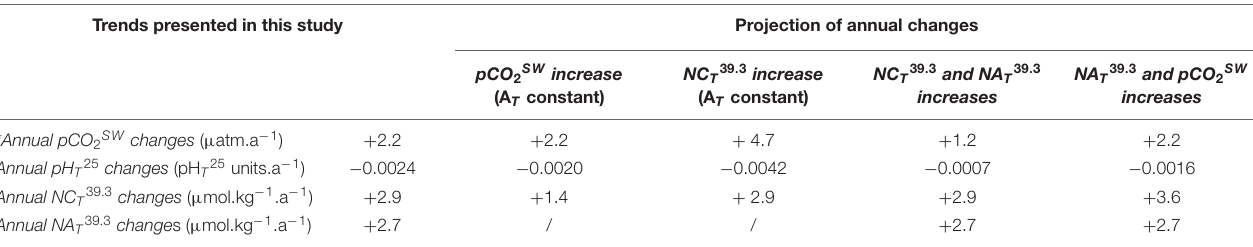
TABLE 3 | Projection of annual changes on the carbonate parameters. Considering the temporal trends calculated in section “Decadal carbonate chemistry Trends in Surface Waters in the NWLB,” changes were calculated by adding the trend values to the mean values estimated for the surface layer (0–50 dbars) of the PERLE area. Trends presented in this study